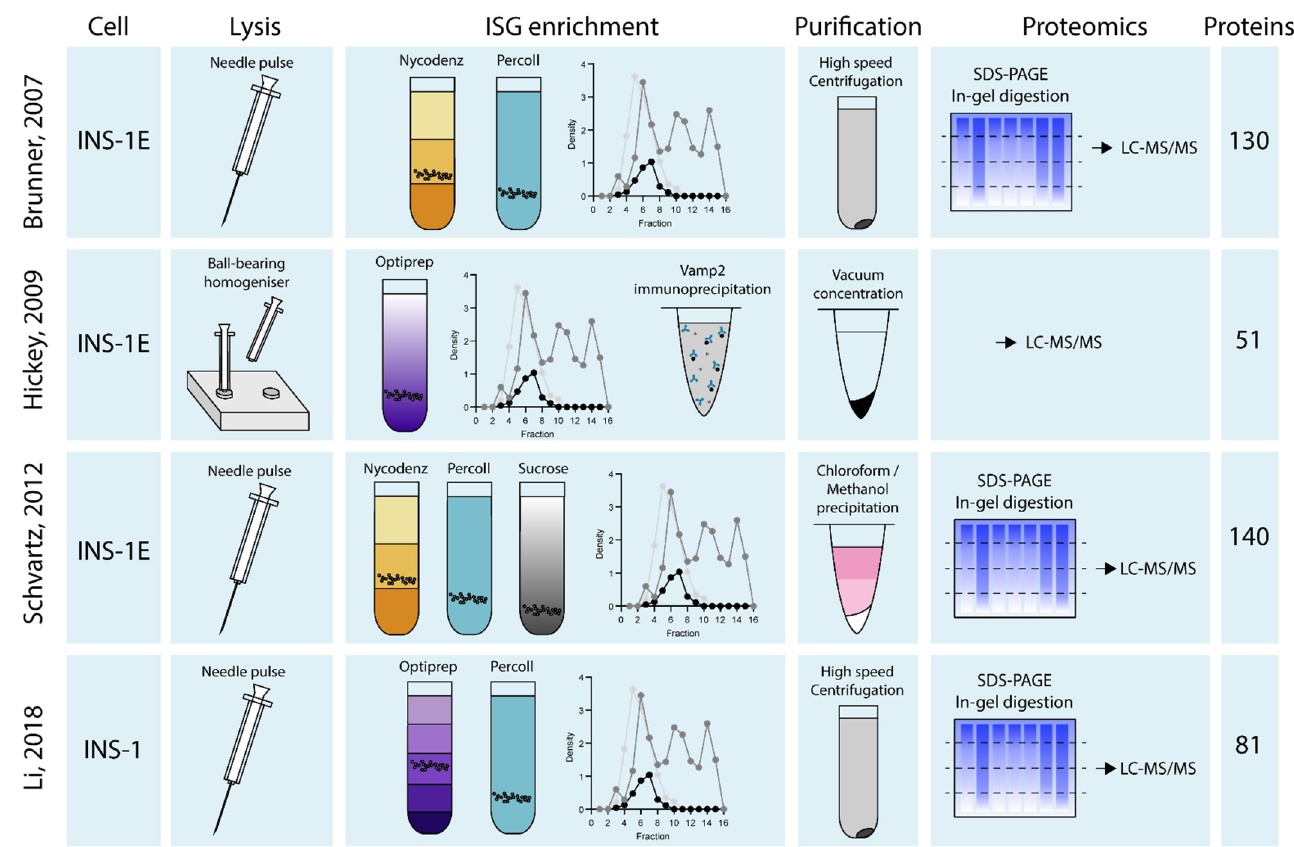
Figure 3. Schematic of insulin granule isolation and purification techniques across the 4 ISG proteomes. Rat insulinoma cells in all ISG proteomic studies are lysed before ISG enrichment through various density gradients or immunoprecipitations. ISG are then purified prior to proteomics analysis by LC-MS/MS to obtain list of ISG proteins. Data collated from Brunner et al., 2007, Hickey et al., 2009, Schvartz et al., 2012 and Li et al., 2018.